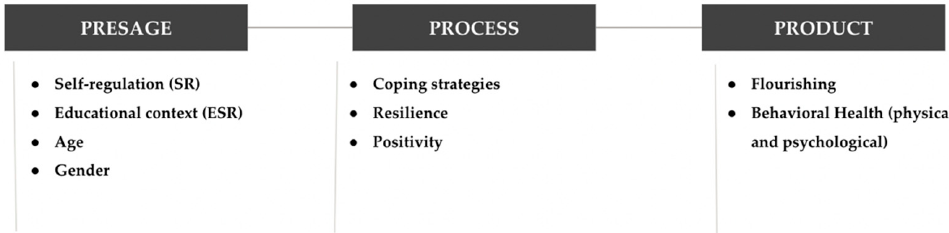
Figure 1. Diagram of the variables included in this study.